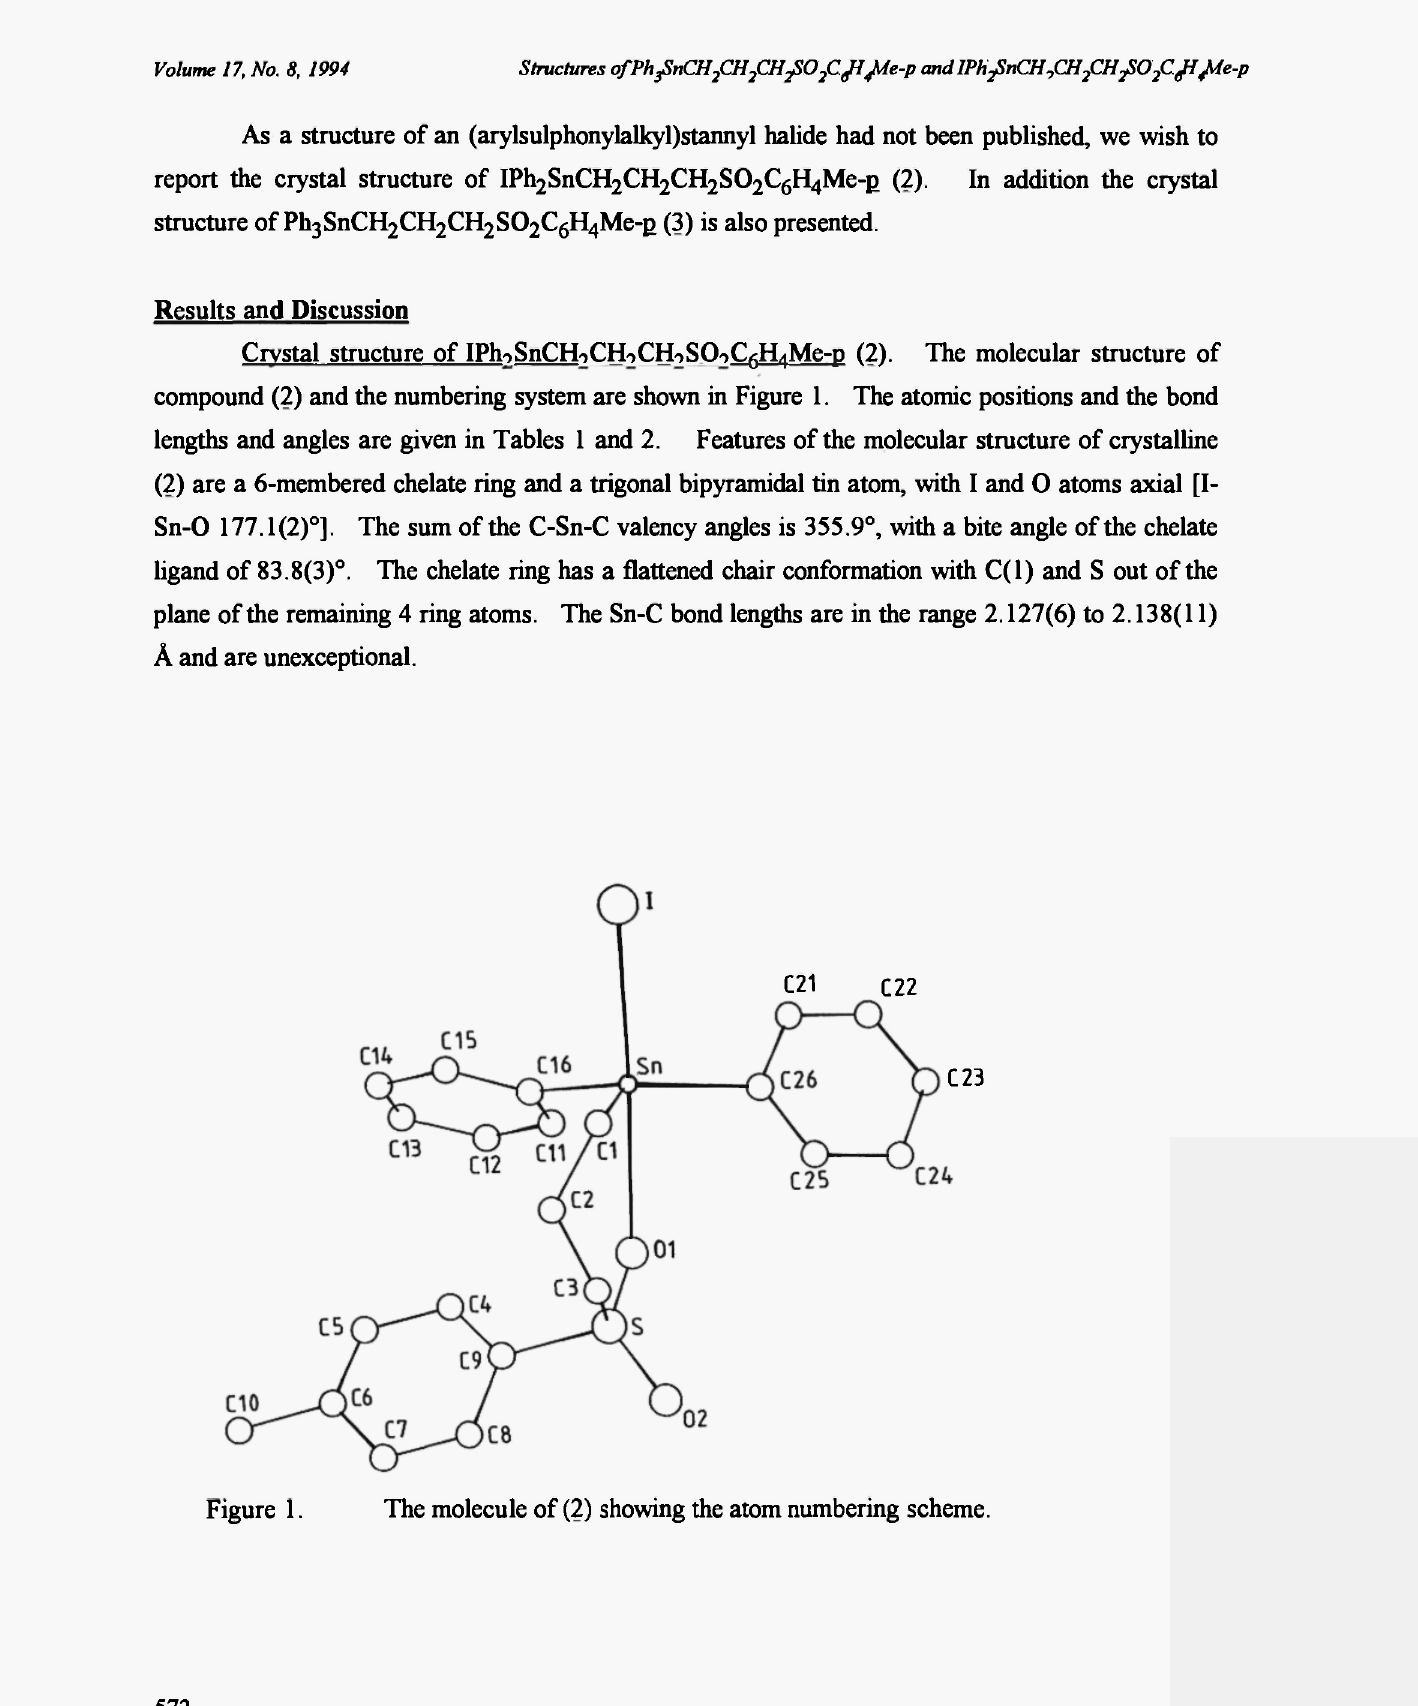
Figure 1. The molecule of (2) showing the atom numbering